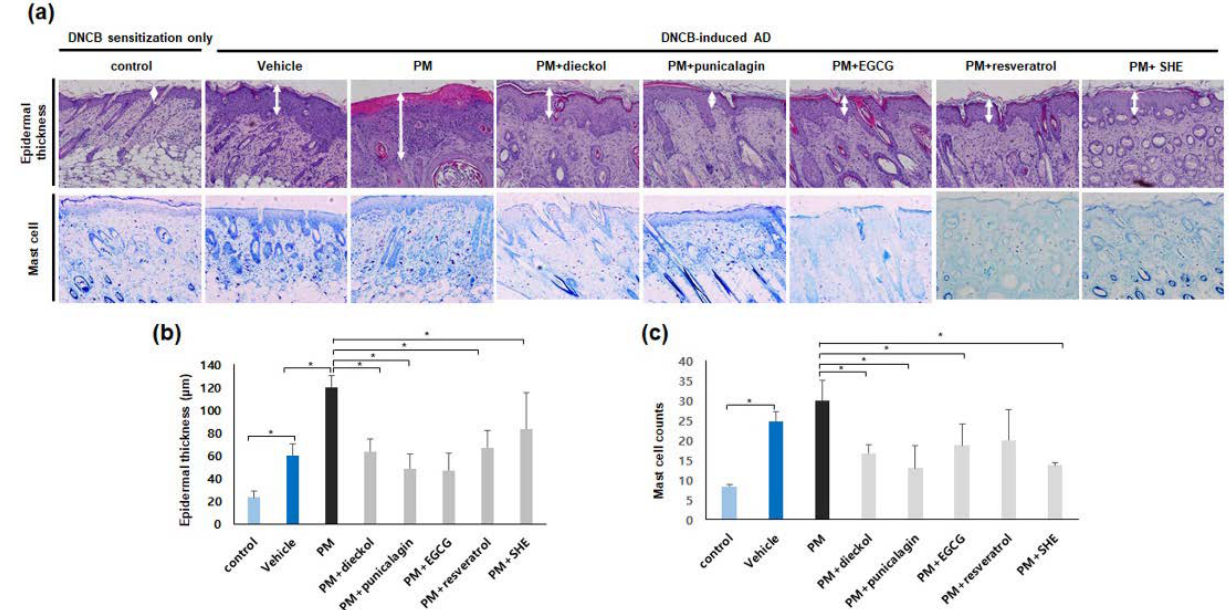
Figure 3. Preventative effects of antioxidants against an increase in epidermal thickness and mast cell counts in the particulate matter <10 μm (PM 10 )-treated, 2,4-dinitrochlorobenzene (DNCB)-induced atopic dermatitis mice. ( a ) Antioxidants showed a decrease in epidermal thickness and mast cell counts in the PM 10 -treated, DNCB-induced atopic dermatitis mice. A white arrows indicate epidermal thickness. The data in the bar graphs represent the mean ± standard deviation (SD) from three independent experiments (* p < 0.05). ( b ) Epidermal thickness was significantly decreased after the combined treatment with dieckol, punicalagin, epigallocatechin-3-gallate (EGCG), resveratrol, or Siegesbeckiae Herba extract (SHE) compared with that after PM 10 treatment only. The data in the bar graphs represent the mean ± SD from three independent experiments (* p < 0.05). ( c ) The number of mast cells was also significantly decreased after the combined treatment with dieckol, punicalagin, EGCG, resveratrol, or SHE compared with that after PM 10 treatment only. The data in the bar graphs represent the mean ± SD from three independent experiments (* p < 0.05).